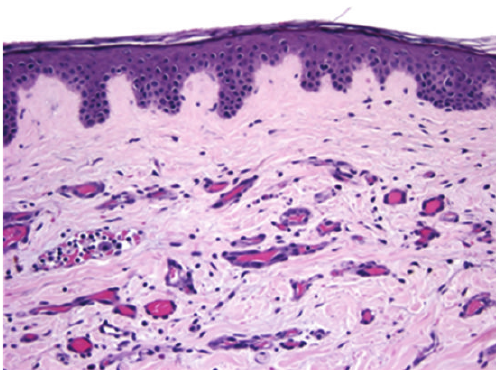
Figure 3: In the breast, most cases of radiation-associated angiosar- coma were cutaneous tumors, evidenced by extensive dermal infiltration in this case (H&E,